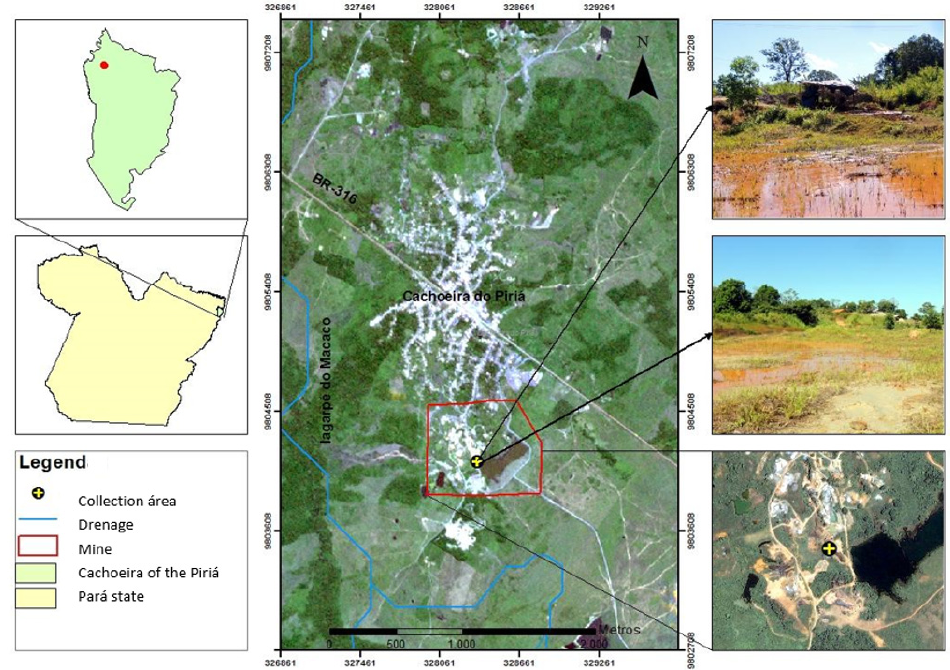
Figure 1. Location of the collection area in the municipality of Cachoeira do Piriá, Pará.